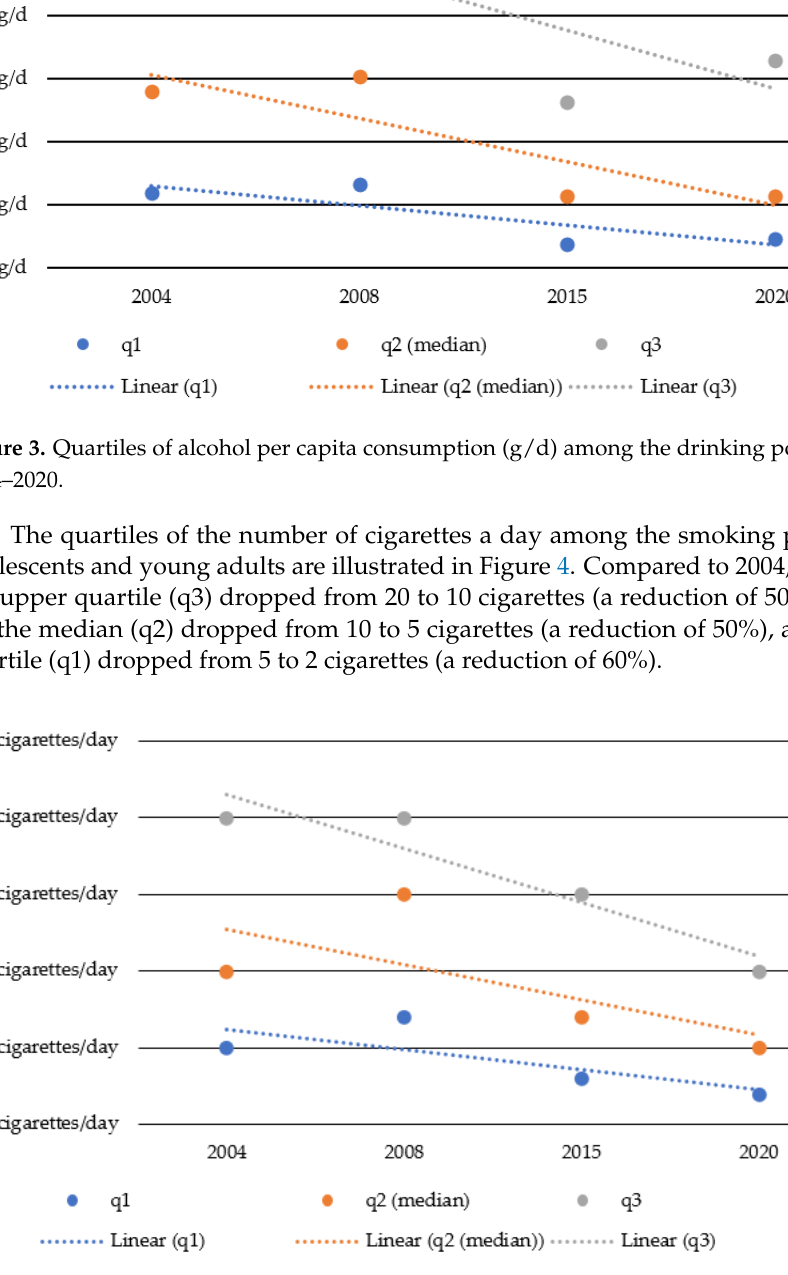
Figure 4. Quartiles of cigarettes a day among the smoking population between 2004 and 2020. Similar to alcohol consumption, the gap between high- and low-level smokers nar- rowed in terms of absolute numbers (from 15 cigarettes difference in 2004 to 8 cigarettes difference in 2020). The decrease in tobacco consumption can be observed at all levels of consumption as